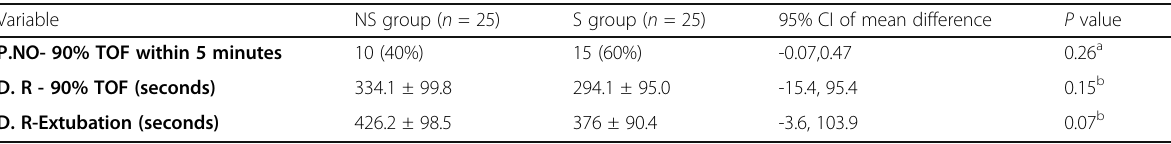
Table 3 Muscle relaxant recovery profile in both groups Variable